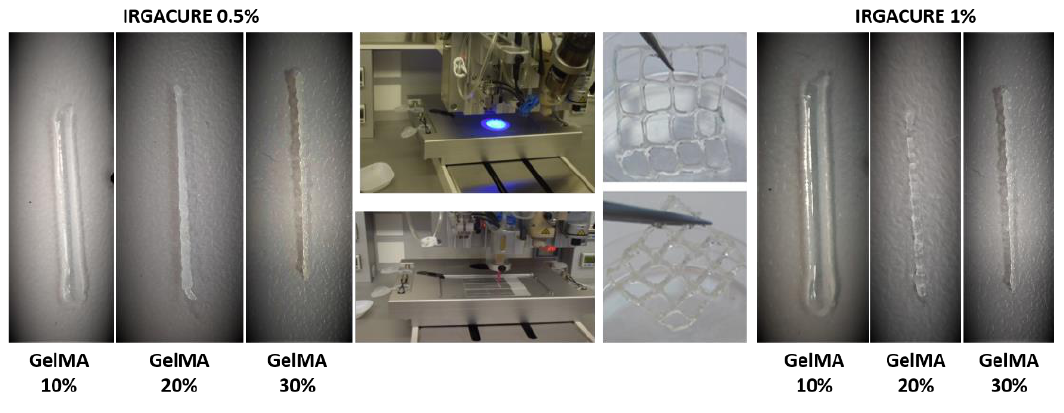
Figure 6. 3D printing process and printing tests.